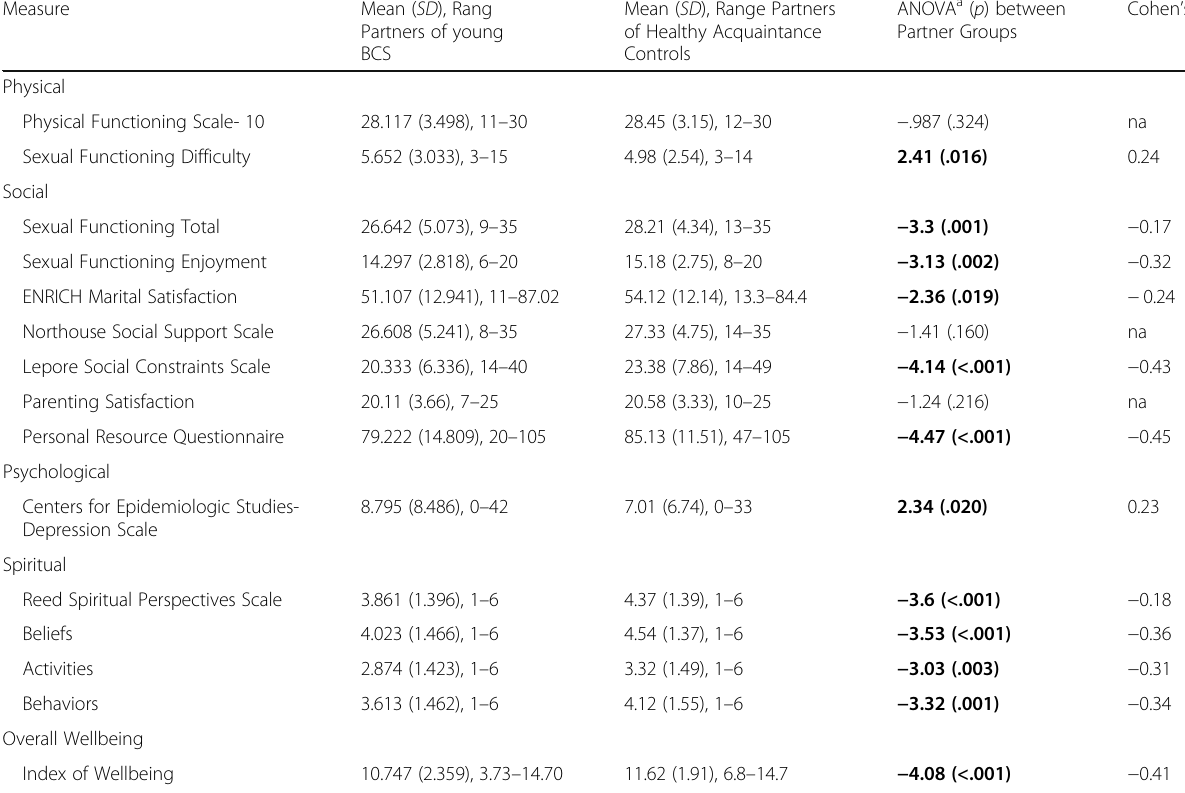
Table 2 Differences between Partners of Young Breast Cancer Survivors and Partners of Healthy Acquaintance Controls Measure